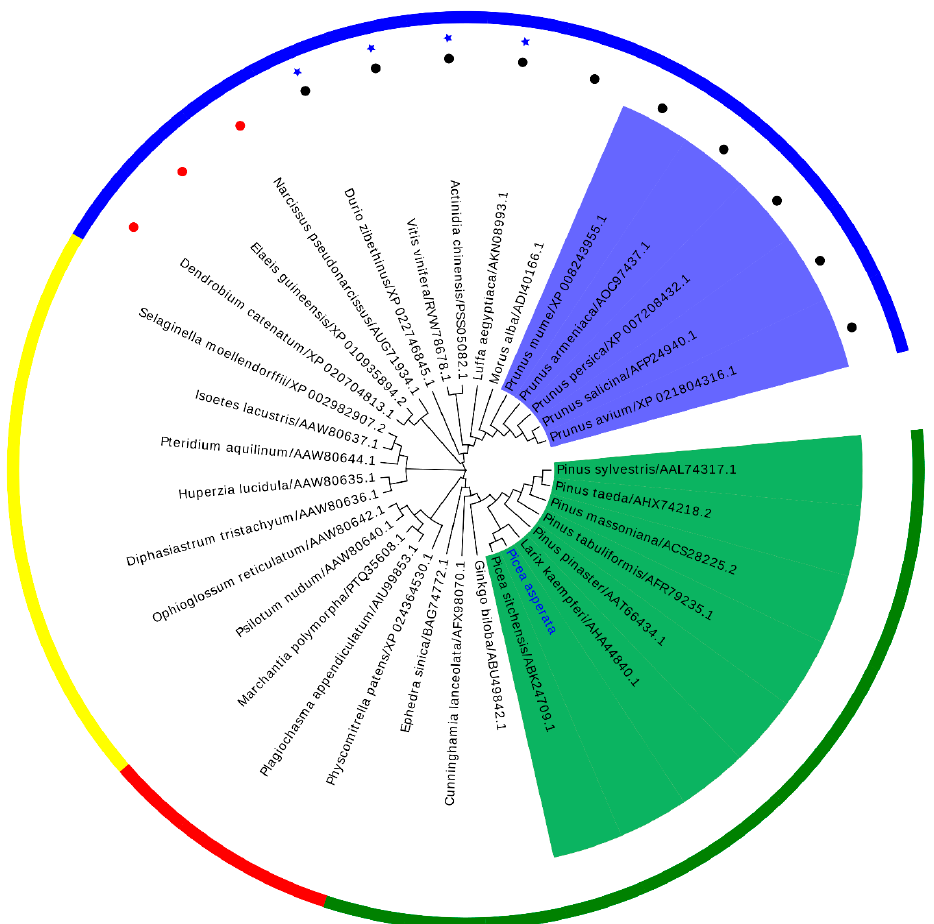
Figure 4. A phylogenetic tree between PaPAL and other plant PALs was constructed by the neighbor-joining (NJ) method. Outer circle: Gymnosperm species are shown in green, bryophyta species in red, pteridophyta species in yellow, angiosperm species in blue. The liana species are represented in ★ . The monocot species and dicotyledon species are represented with ● and ● , respectively. Inner ring: Rosaceae species are indicated with a blue background and Pinaceae species with a green background.